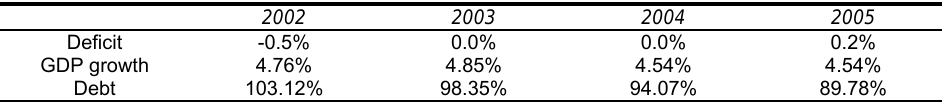
Table 7. Italian government deficit plan starting in 2002, submitted in November 2001